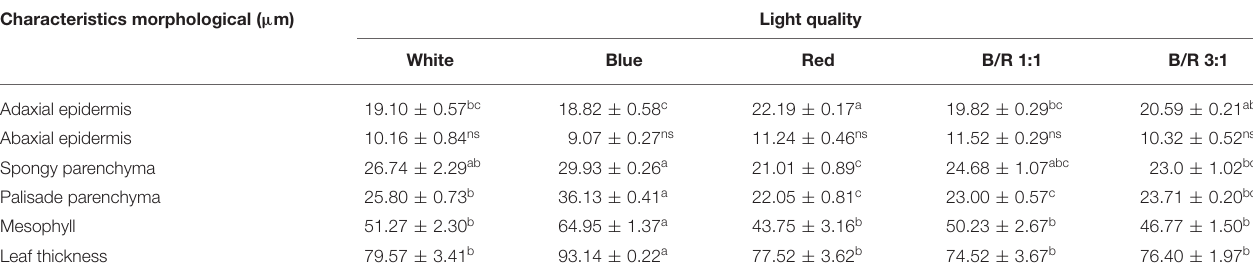
TABLE 3 | Leaf anatomical structure parameters of Brosimum gaudichaudii seedlings grown in vitro under different LED spectra for 50 days. Characteristics morphological ( µ m)